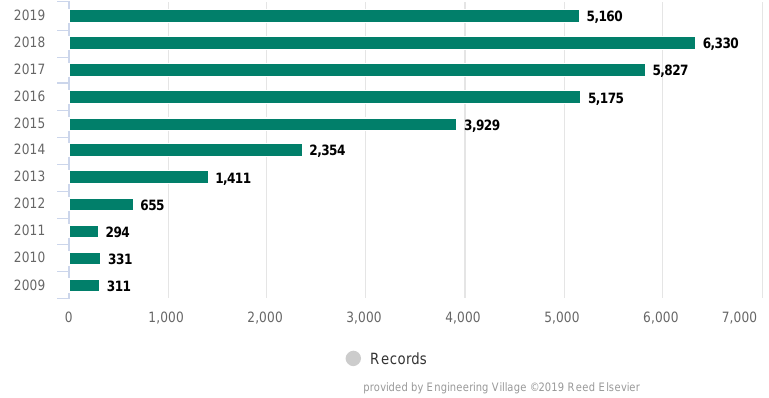
Figure 2. Distribution of papers in EI until Dec